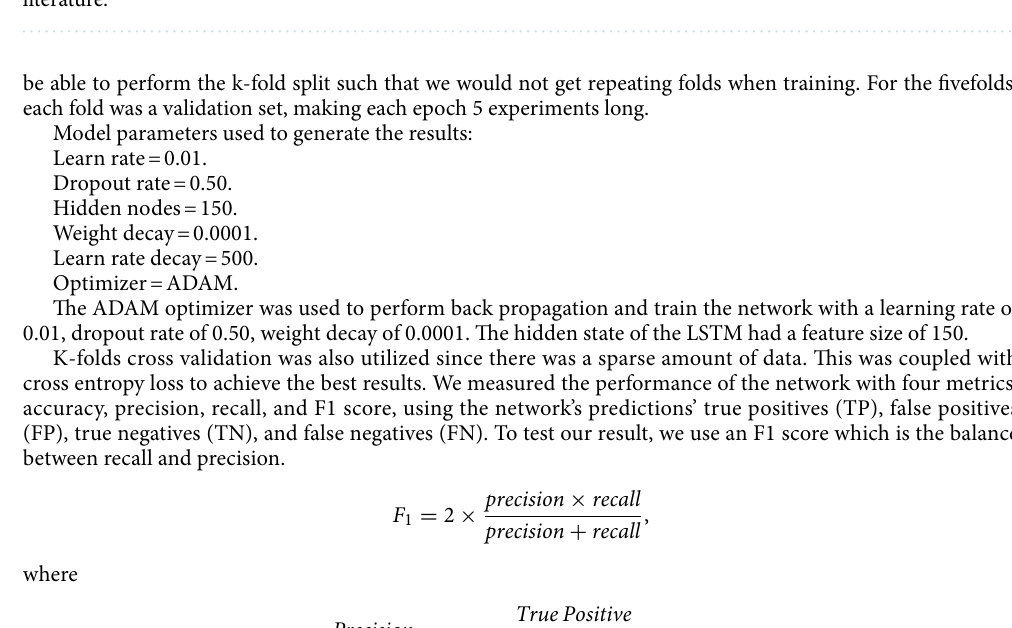
Figure 4. The bi-directional LSTM model to recognize protein subcellular localisation from published